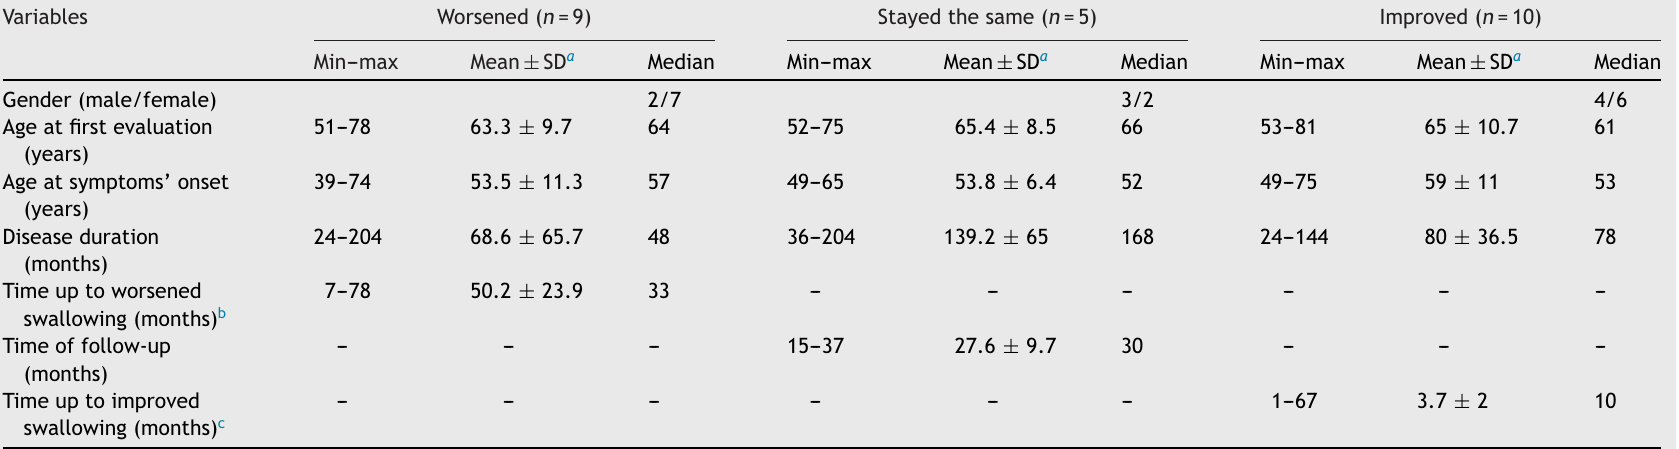
Descriptive analysis of clinical aspects of a case series of patients with Parkinson’s disease followed in a dysphagia outpatient between 2006 and 2011, stratified by swallowing functionality ( n =